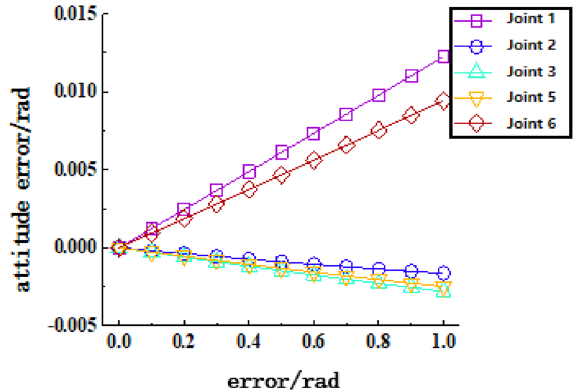
Figure 16. Joint clearance deflection error-terminal attitude sensitivity curve.